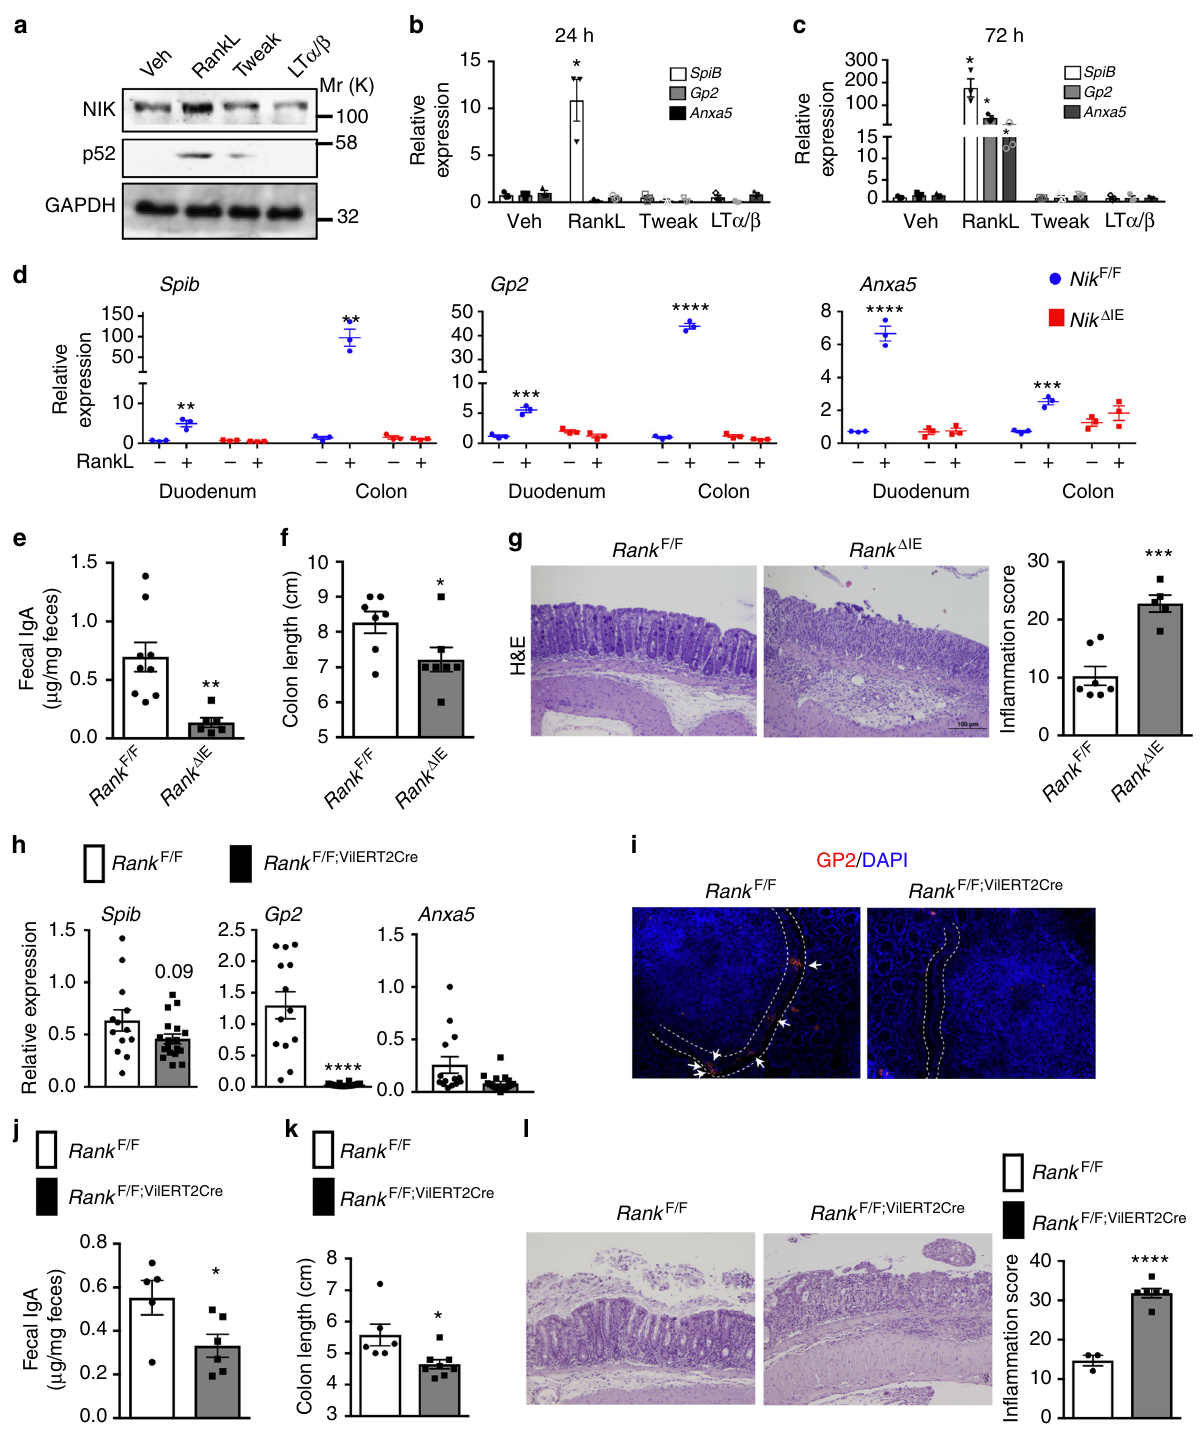
Fig. 3 Epithelial RANK signaling protects against colitis. a Western blot analysis for NIK and p52 in the enteroid cultures treated with vehicle, RANKL, Tweak or LT α / β for 24 h. b , c qPCR analysis of M-cell markers in the duodenal enteroids treated with vehicle, RANKL, Tweak or LT α / β for 24h ( b ) or 72